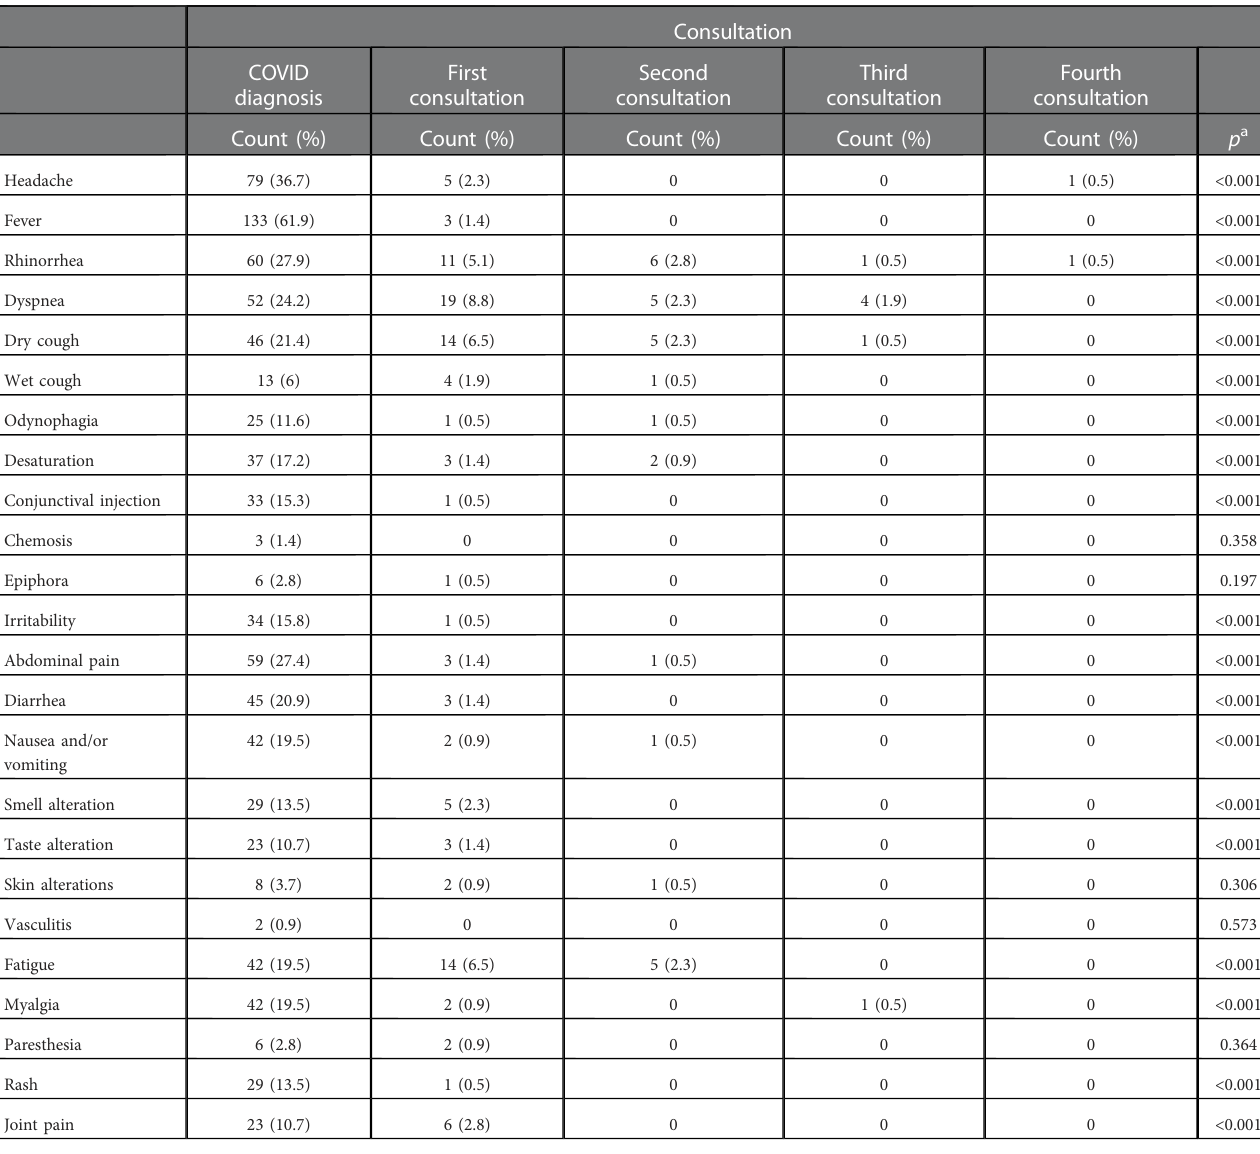
TABLE 2 Symptoms at diagnosis and follow-up consultations.